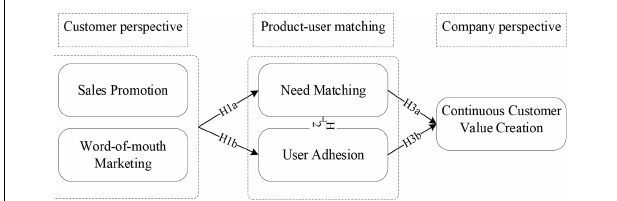
FIGURE 1 | Conceptual